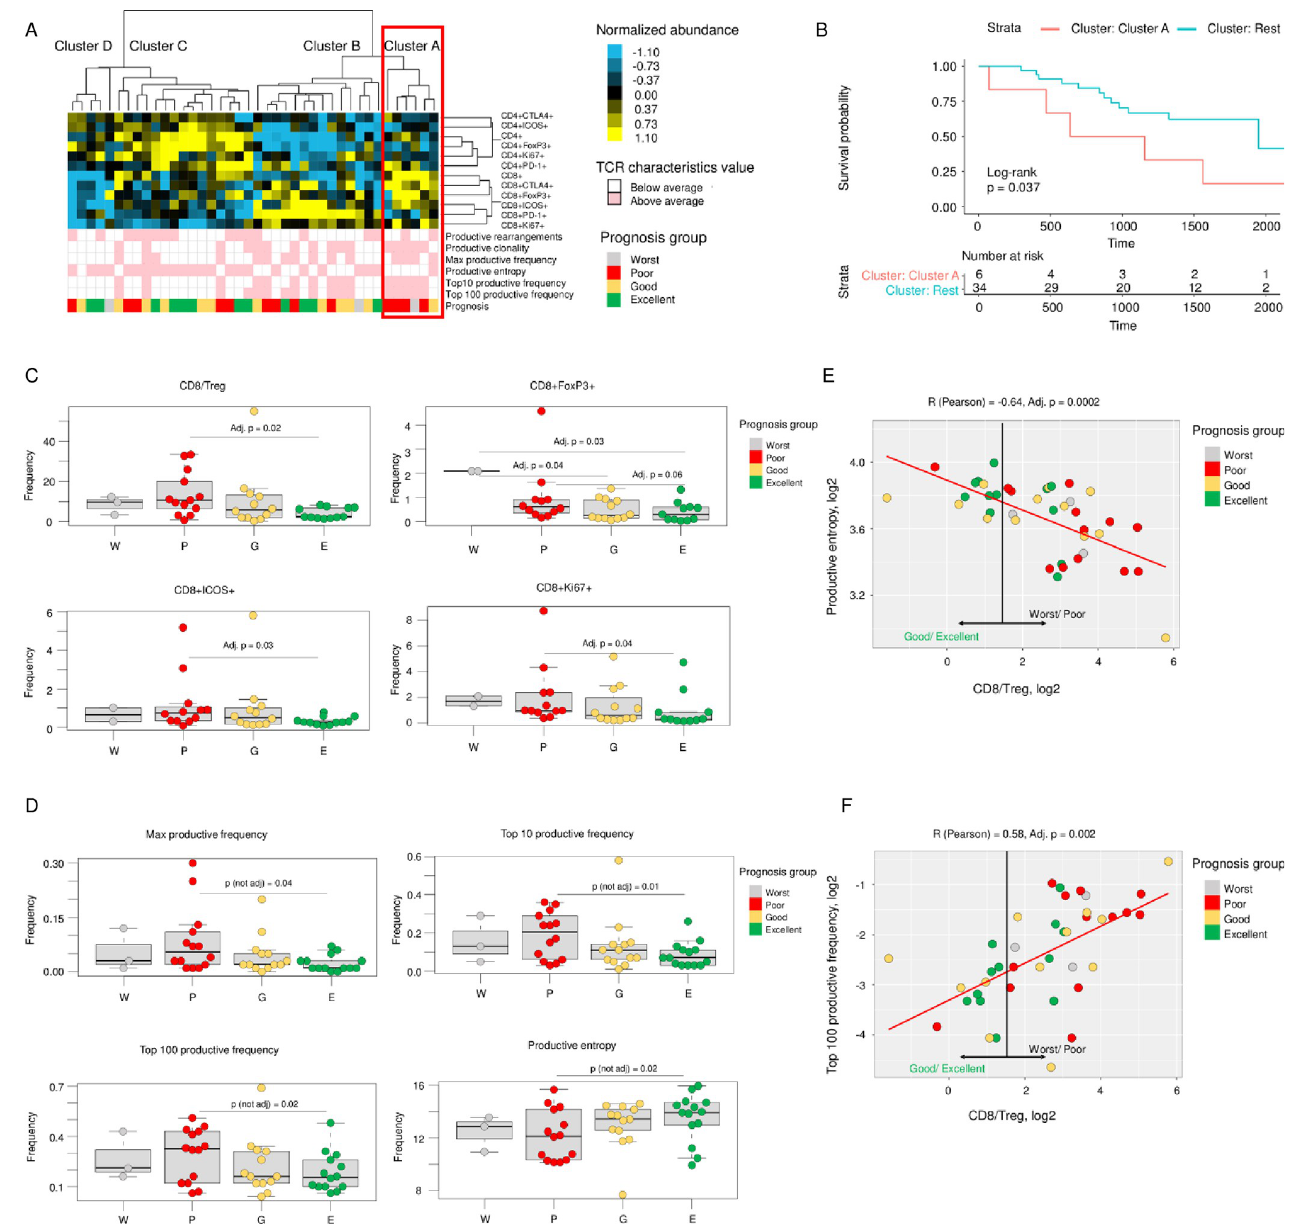
Fig 1. Association of immune characteristics determined by flow cytometry and T cell receptor (TCR) sequencing with patient prognosis. (A) Unsupervised hierarchical clustering of samples (columns) in terms of the profile of immune marker abundance determined by flow cytometry. Cell color in the heatmap shows normalized abundance of immune markers, from low (blue) to high (yellow). Pink and white boxes show values of TCR characteristics; pink indicates an above-average value and white indicates a below-average value for each characteristic: productive rearrangement, productive clonality, productive entropy, top 10 productive frequency, and top 100 productive frequency. Cluster A (red square) is enriched with patients with a poor or worst prognosis; no patients in this cluster had an excellent prognosis. (B) Kaplan–Meier curves of overall survival in patients grouped in Cluster A and in the remaining clusters by hierarchical clustering. (C) CD8+ T cell subpopulations were significantly decreased in ascites from patients with an excellent prognosis compared with ascites from patients with a poor prognosis. The y-axis shows the percentage of CD3+ cells (log 2 ). CD8/Treg is the ratio of the percentage of live CD8+ lymphocytes to the percentage of live CD4+FoxP3+ lymphocytes. Each box plot represents the median and the twenty-fifth and seventy-fifth percentiles. Only significant associations are shown. (D) Significant differences in ascites TCR characteristics between patients with excellent and poor prognosis. The y- axis shows the percentage of CD3+ cells (log 2 ). (E) Scatterplots of CD8/Treg with productive entropy. (F) Scatterplots of CD8/Treg with top 100 productive frequency. Good/excellent prognosis was associated with less abundant CD8/Treg, increased productive entropy, and decreased top 100 productive frequency.